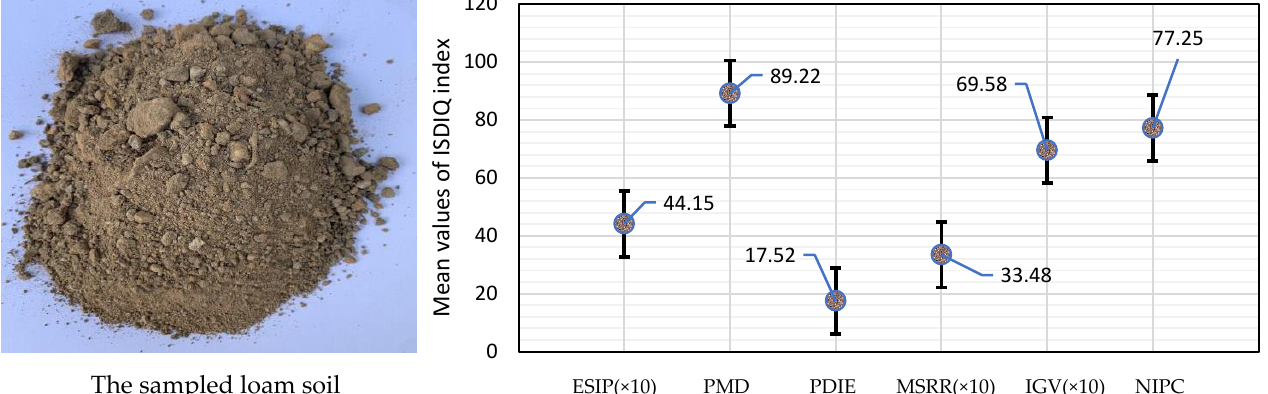
Figure 4. The loam soil specimen and its corresponding SDIQ index values obtained from the sampled layer A.